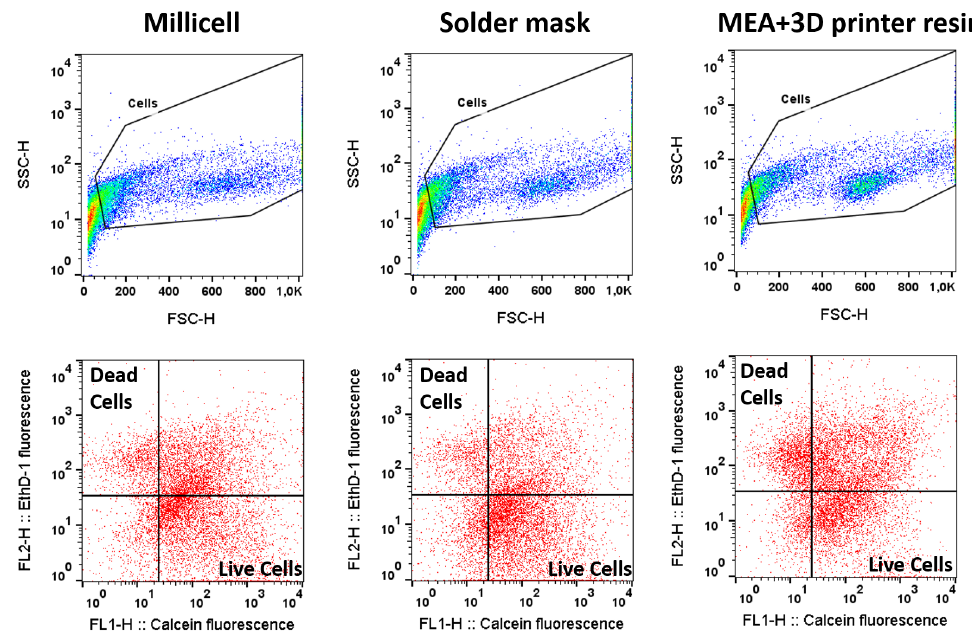
Figure 4. Biocompatibility measured in open culture systems. Representative images of cytometer acquisition data of cells cultured on Millicell insert, on solder mask, and on MEA + 3D printer resin, as shown from left to right. The upper row shows the gating of single cells. The lower row shows calcein fluorescence in the x-axis and ethidium fluorescence in the y-axis, corresponding to live and dead cells, respectively.